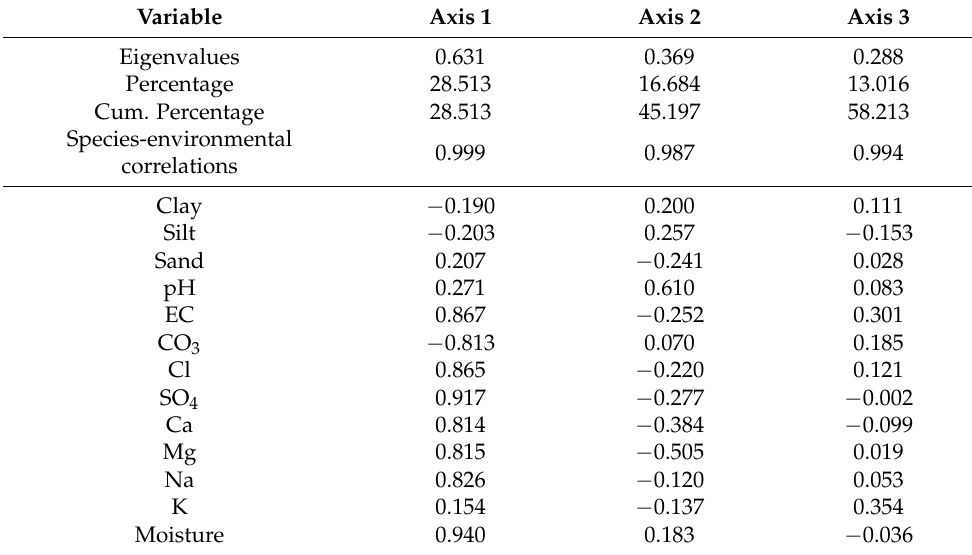
Table 3. Inter-set correlations between environmental variables and site scores with CCA axes.